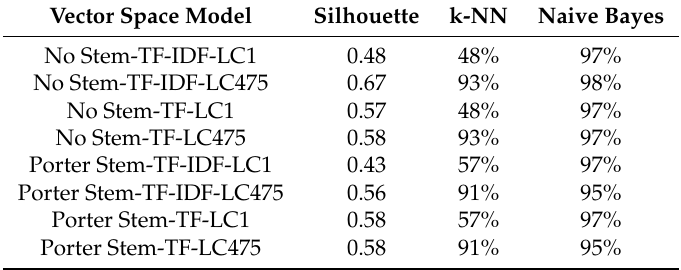
Table 1. Silhouette coefficient evaluated for each projection presented in Figure 4 and the classification rate from the k-NN and naive Bayes classifiers: vector space models from the CBR-ILP-IR dataset.